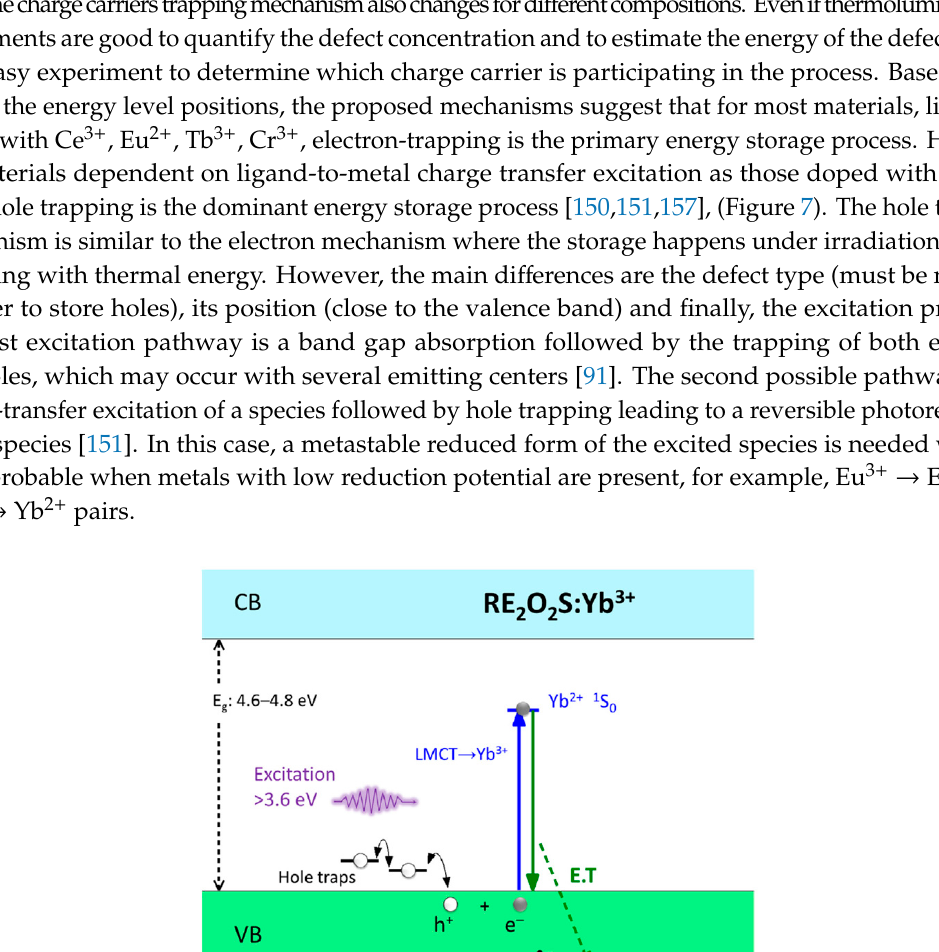
Figure6. PeLsimplifiedmechanism. VBisthevalenceband,CBconductingband,andkTisthermalenergy. Thechargecarrierstrappingmechanismalsochangesfordifferentcompositions. Evenifthermoluminescence